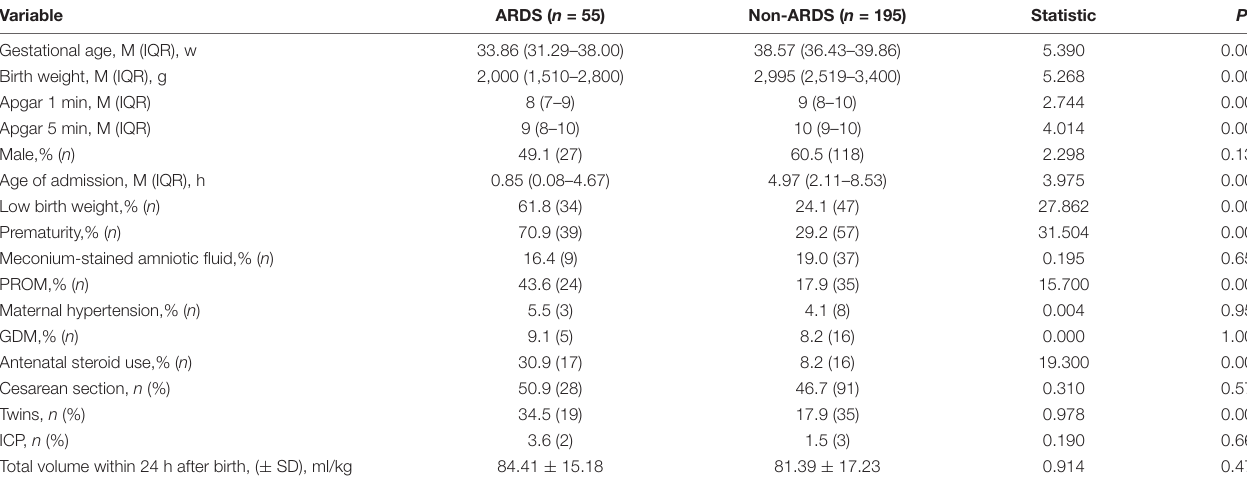
TABLE 1 | Demographic characteristics of infants enrolled in the present study. Variable ARDS ( n = 55) Statistic